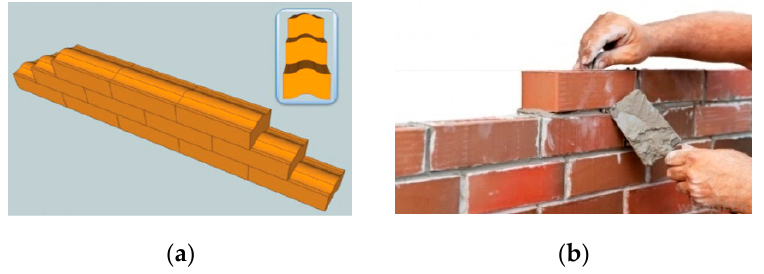
Figure 1. Infill materials: ( a ) semi-interlocked masonry (SIM); ( b ) unreinforced masonry (URM)